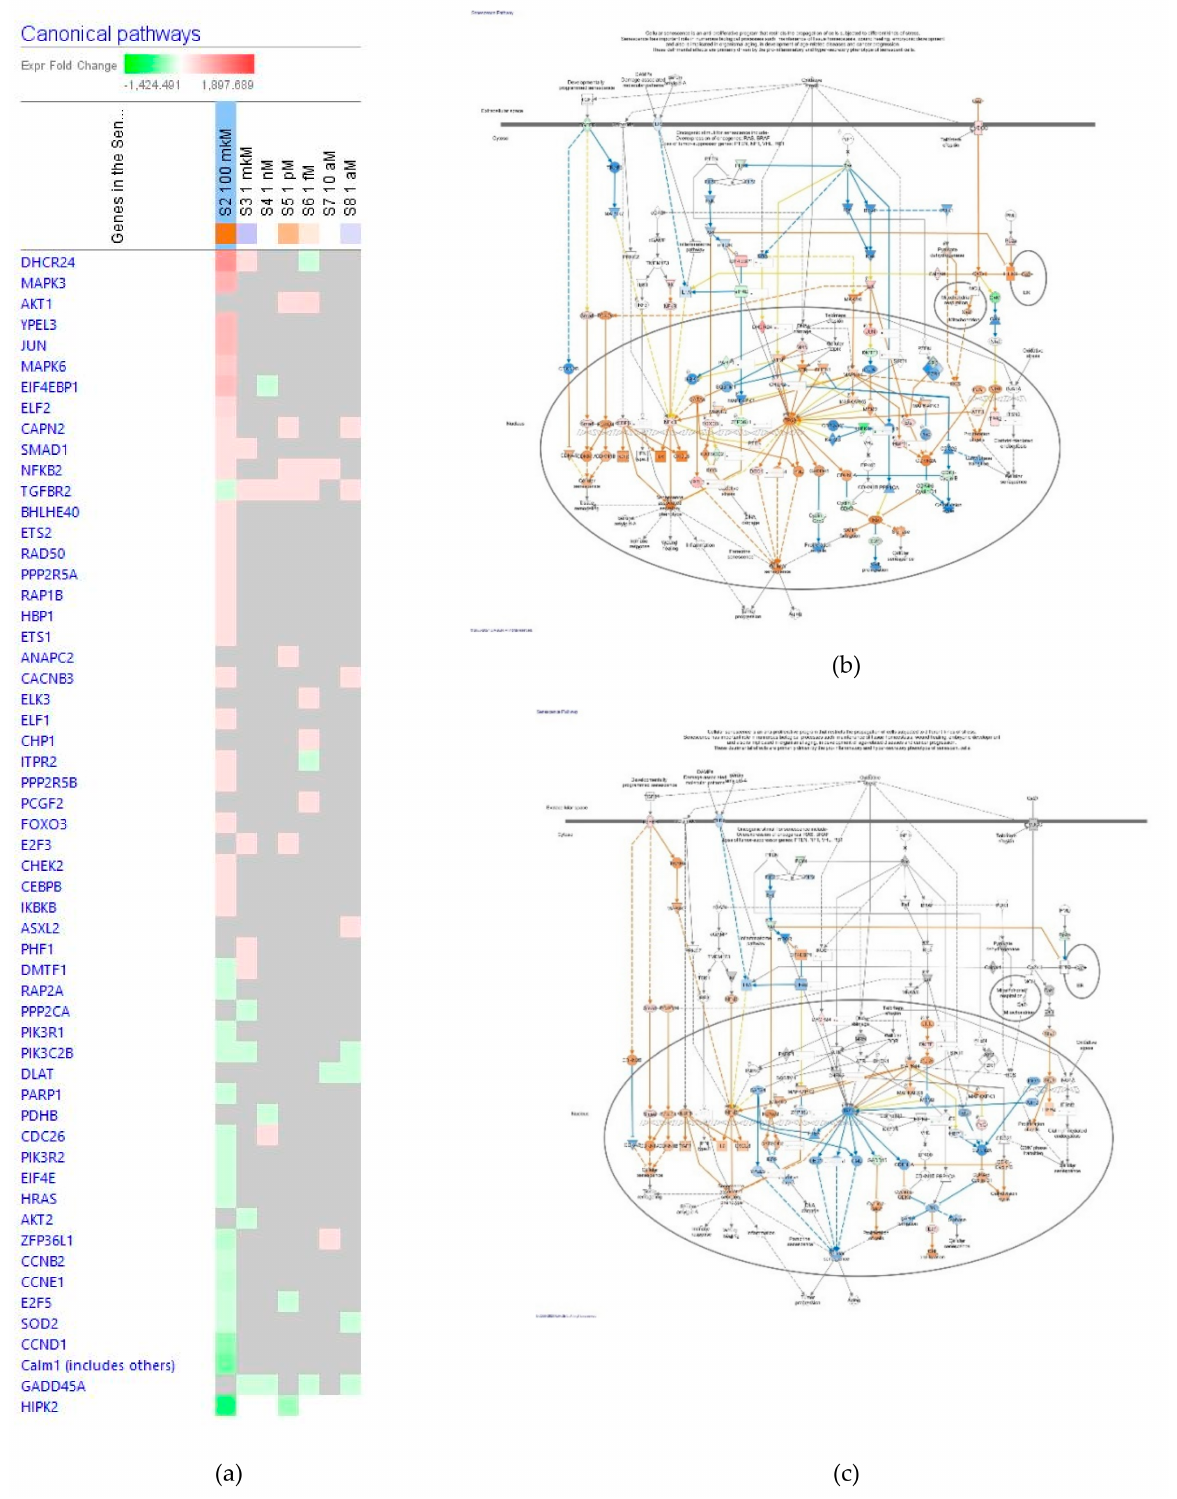
Figure 8. Effect of Rg5 on senescence signaling pathway: ( a ) Heatmap of gene expression (in fold changes compared to control, red, upregulation and green, downregulation), after exposure with ginsenoside Rg5 at different concentrations; the 100 µ M signature is shown in the leftmost column as solid red or green squares indicating genes that are upregulated or downregulated, respectively; color intensity indicates the actual log-fold changes; ( b ) Rg5 at a concentration of 100 µ M— predicted inhibition (blue) and activation (brown); ( c ) Rg5 at a concentration of 1 µ M—predicted inhibition (blue) and activation